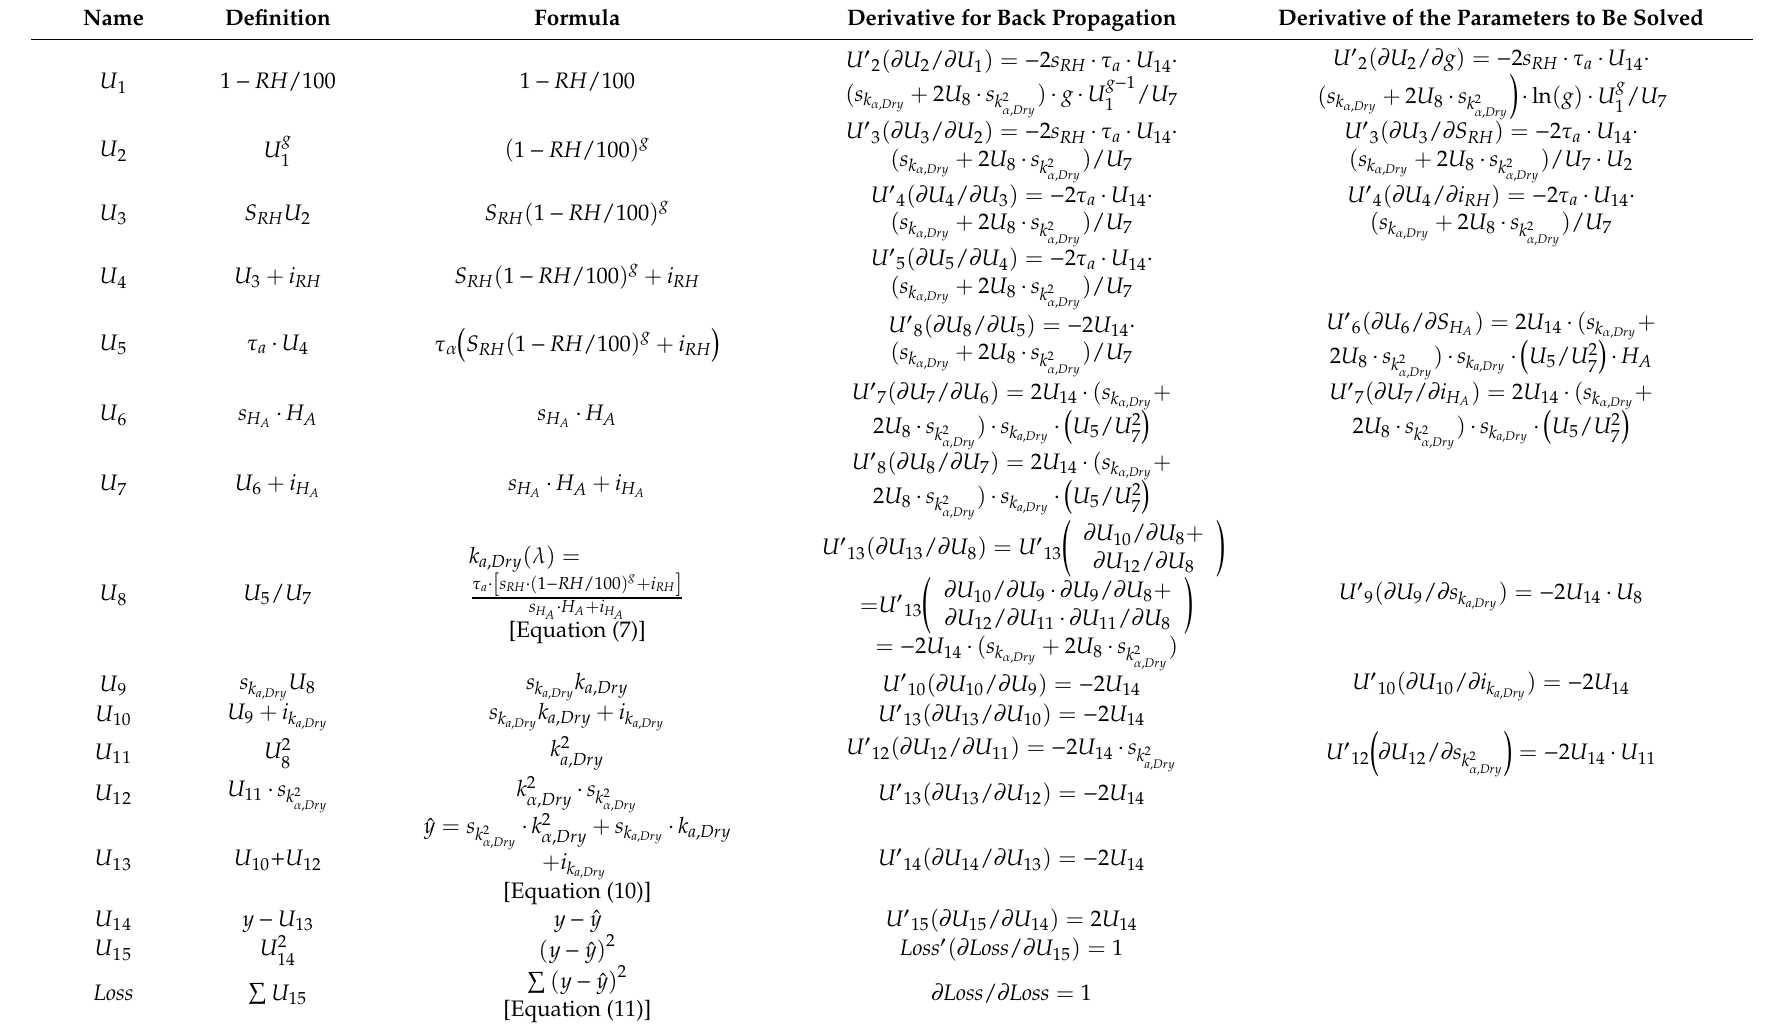
Table 1. Nodes and their derivatives in the computational graph for conversion from satellite AOD to ground aerosol coe ffi cient